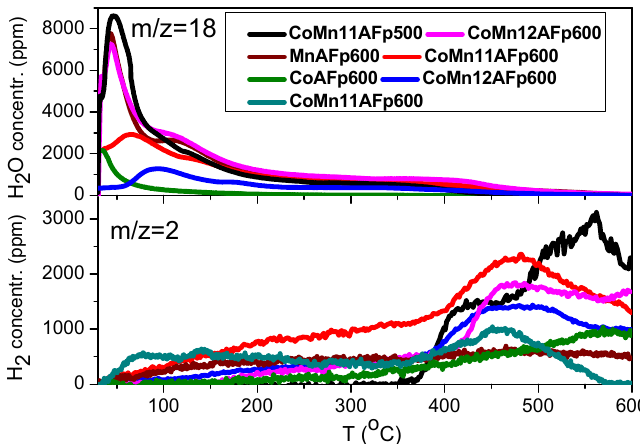
Figure 5. TPD profiles of H 2 O and H 2 after water adsorption at 300 °C over pyrolyzed catalysts. Quantitative results of the total adsorbed water (mmol ∙ g − 1 ) at 300 °C (sum of water absorbed at